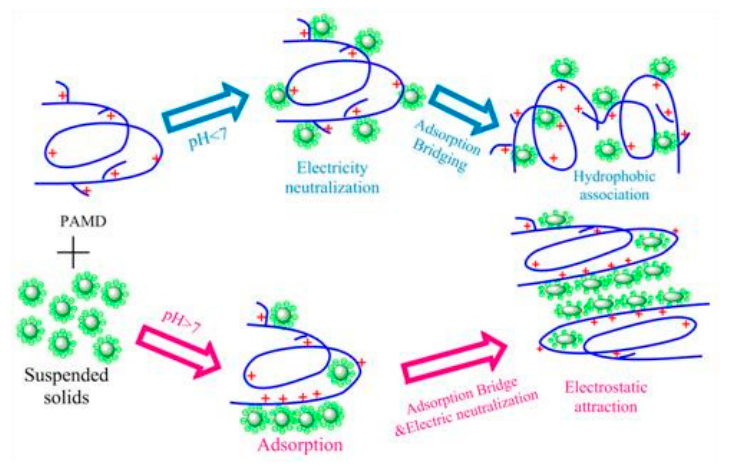
Figure 11. Flocculation mechanisms for PAMD.